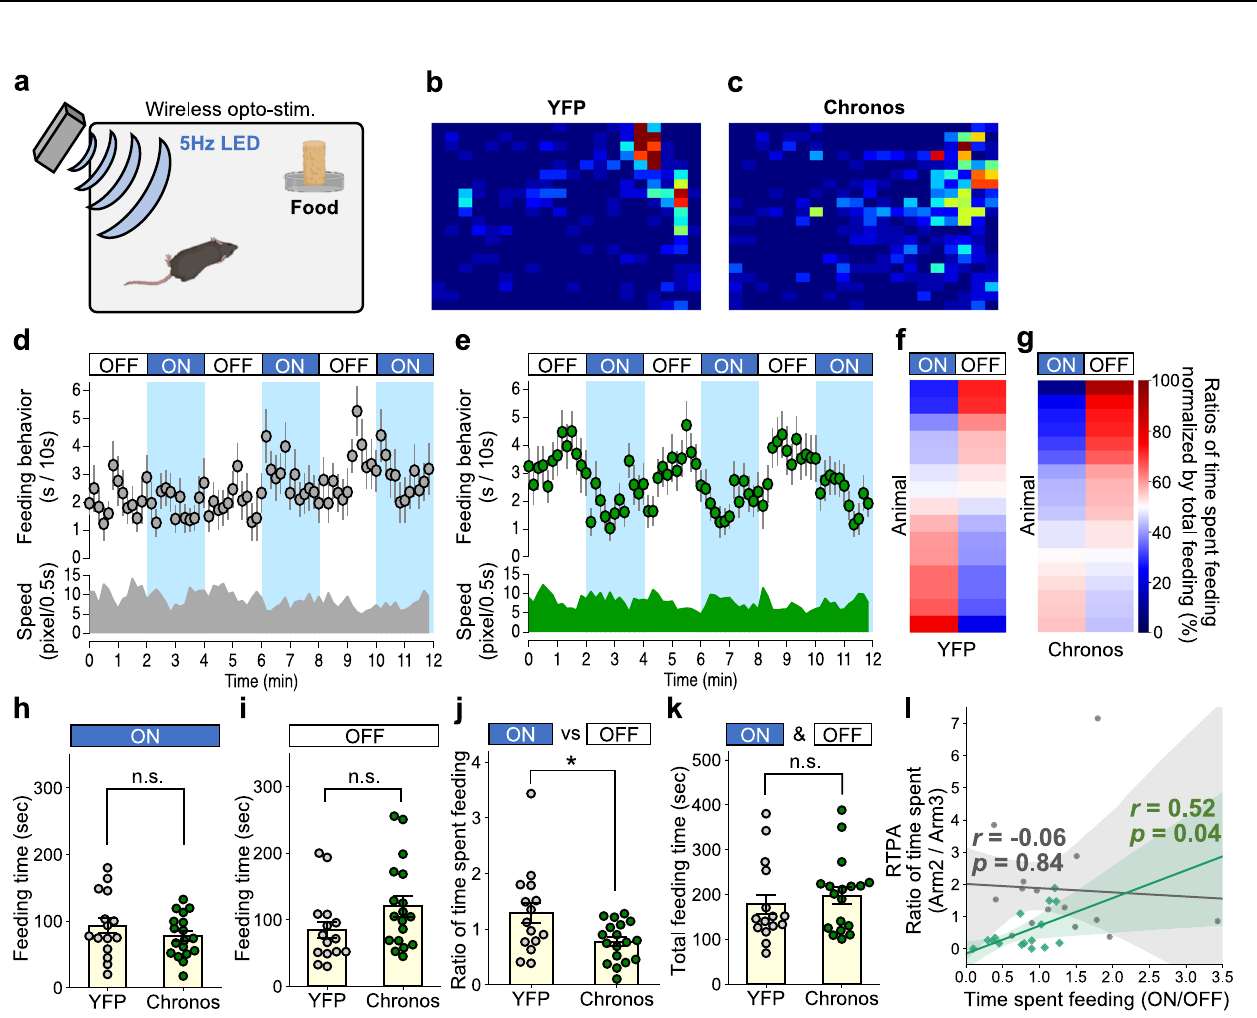
Fig. 2 | Photoactivation of the lPB-PSTN promotes avoidance behavior and aversive learning. a Schematic of microinjection and placement of the LED can- nula unit of the C57BL/6J mouse. b Images of the projection site, in the PSTN(top) andtheinjectionsiteinthelPB(bottom).Thedashedlineinthetopimageindicates the position of the optic fi ber. Scale bars, 200 μ m. scp, superior cerebellar ped- uncle.Morethan fi veindependentexperimentswereconductedandsimilarresults wereobtained. c SchematicillustrationsoftheY-shapedapparatus. d Experimental schedule of the place avoidance test. e , f Density plots and a scatter plot showing thepositionofarepresentativeYFP( e )andChronos( f )mouseevery0.5sinthe10- min conditioning session (top). Time spent in each arm during each 2-min interval (bottom) (YFP, n =15; Chronos, n =16). g , h Summaryofratiosof timespentinand entries into Arm 2/Arm 3 for 5 – 10min of the conditioning session (YFP, n =15; Chronos, n =16). i , j Heatmaps represent averaged moving speed of each mouse during the 10-min conditioning session. k Average speed for a second after mice